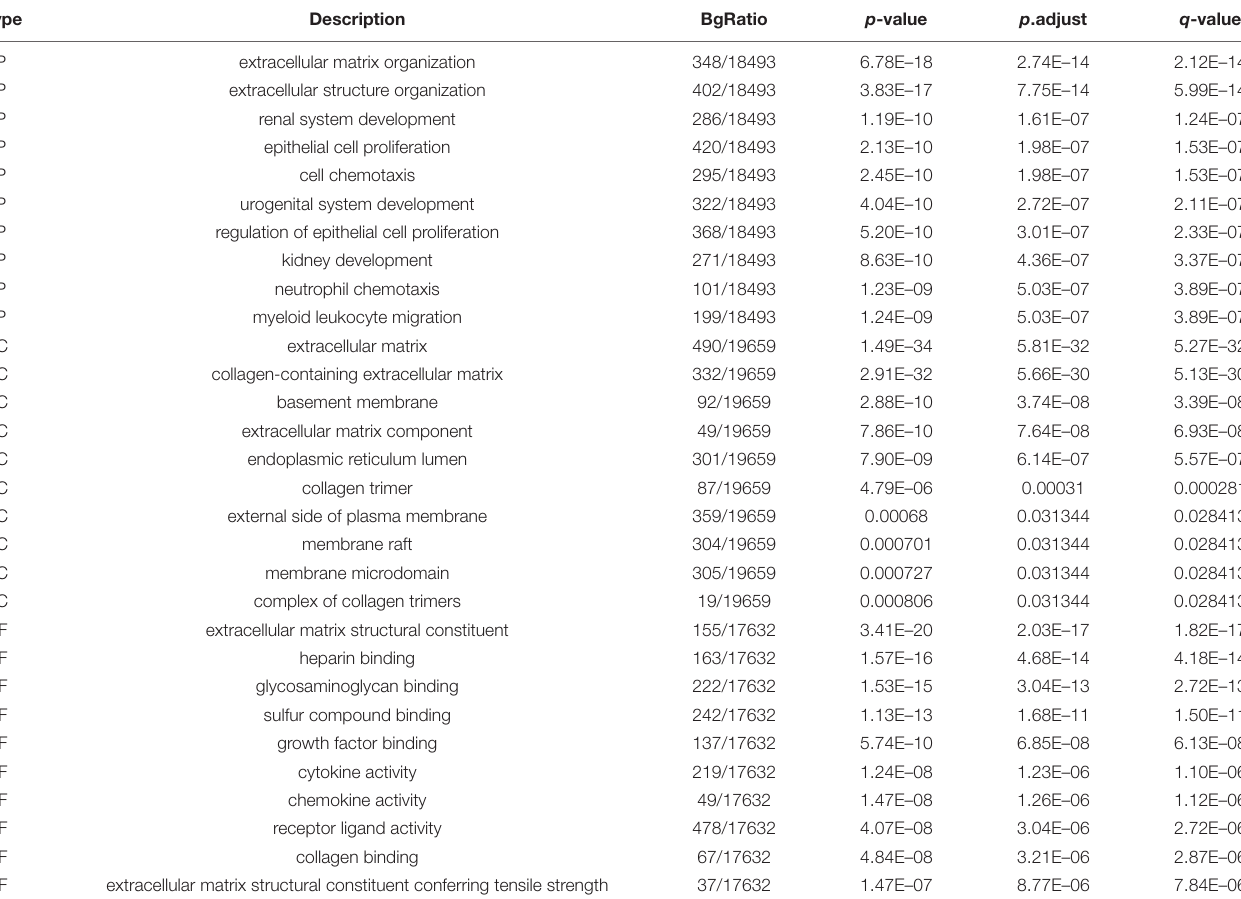
TABLE 1 | GO enrichment analysis for